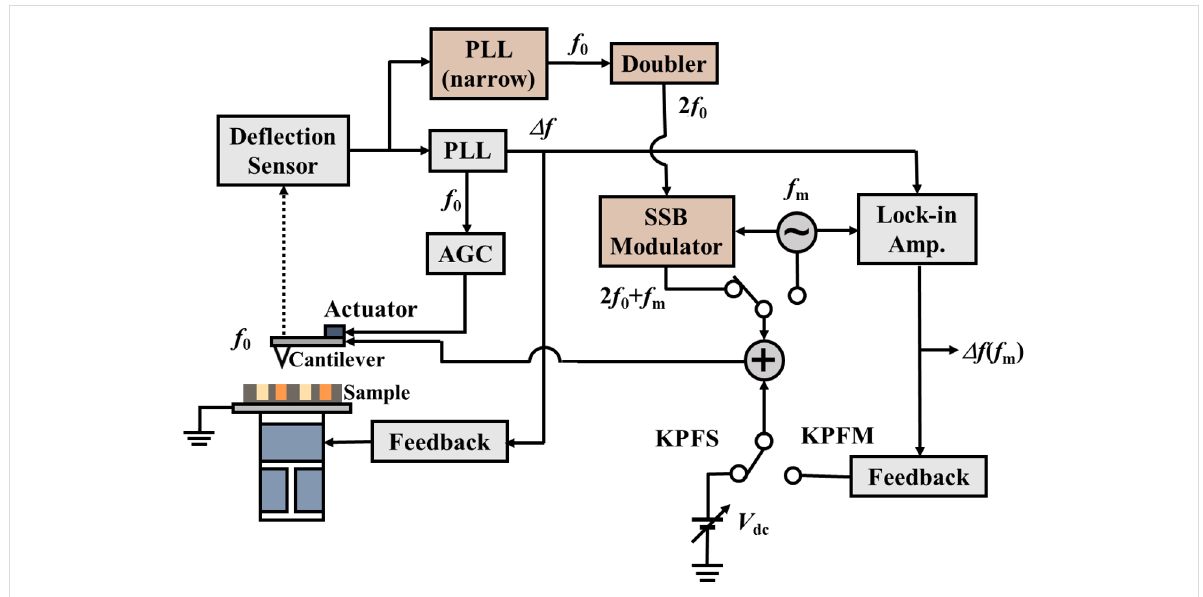
Figure 4: Block diagram of AFM and high–low KPFS. In low KPFS, a signal V ac ·cos 2 π f m t is generated by the oscillator. In high KPFS, a signal cos 2 π (2 f 0 ) t of twice the resonance frequency synchronized with the cantilever oscillation is generated by the PLL and the doubler, and a signal V ac ·cos 2 π (2 f 0 + f m ) t is generated by mixing the signal cos 2 π (2 f 0 ) t and the signal cos 2 π f m t in the SSB modulator. The figure was adapted from [20] (© 2020 Y. Sugawara et al., published by IOP Publishing Ltd., distributed under the terms of the Creative Commons Attribution 4.0 International License, https://creativecommons.org/licenses/by/4.0)